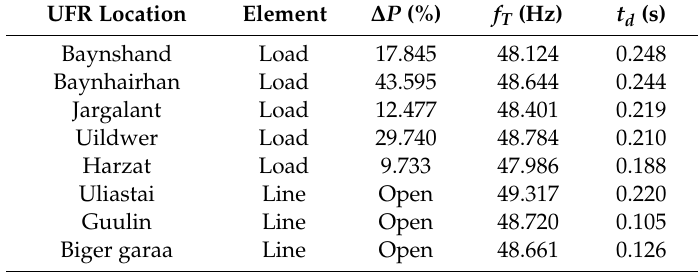
Table 3. Optimal UFLS settings of high inertia—summer season scenario of AURPS.